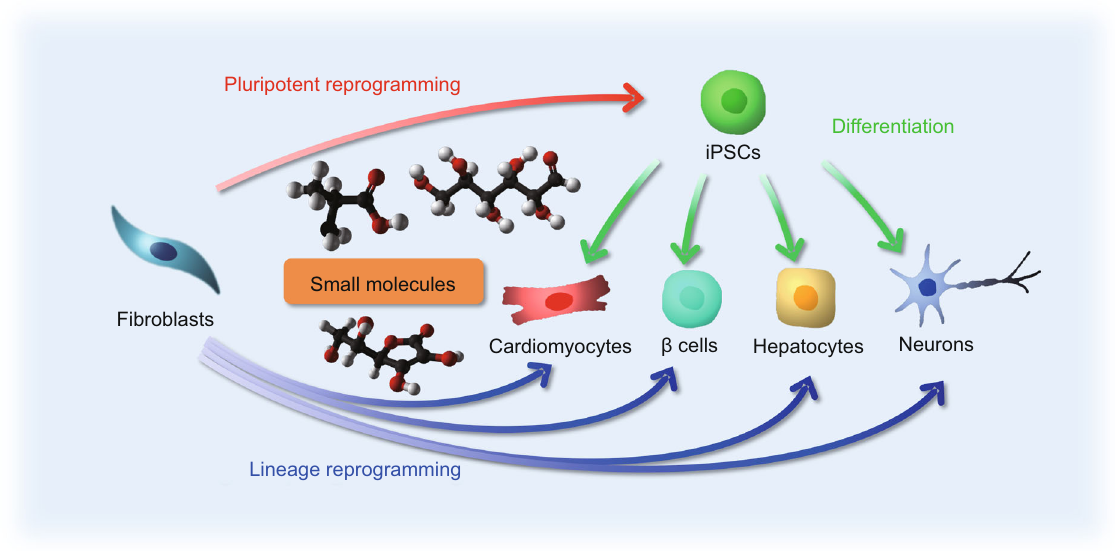
Figure 1. Reprogramming cell fates by small molecules. Chemical approaches can be widely applied to manipulate cell fates and states, including pluripotent reprogramming, directed differentiation, and lineage reprogramming. Small molecules not only are useful in generating functional cell types, such as cardiomyocytes, hepatocytes, pancreatic β cells, and neurons, but also can provide a better understanding of the detailed mechanisms underlying speci fi c